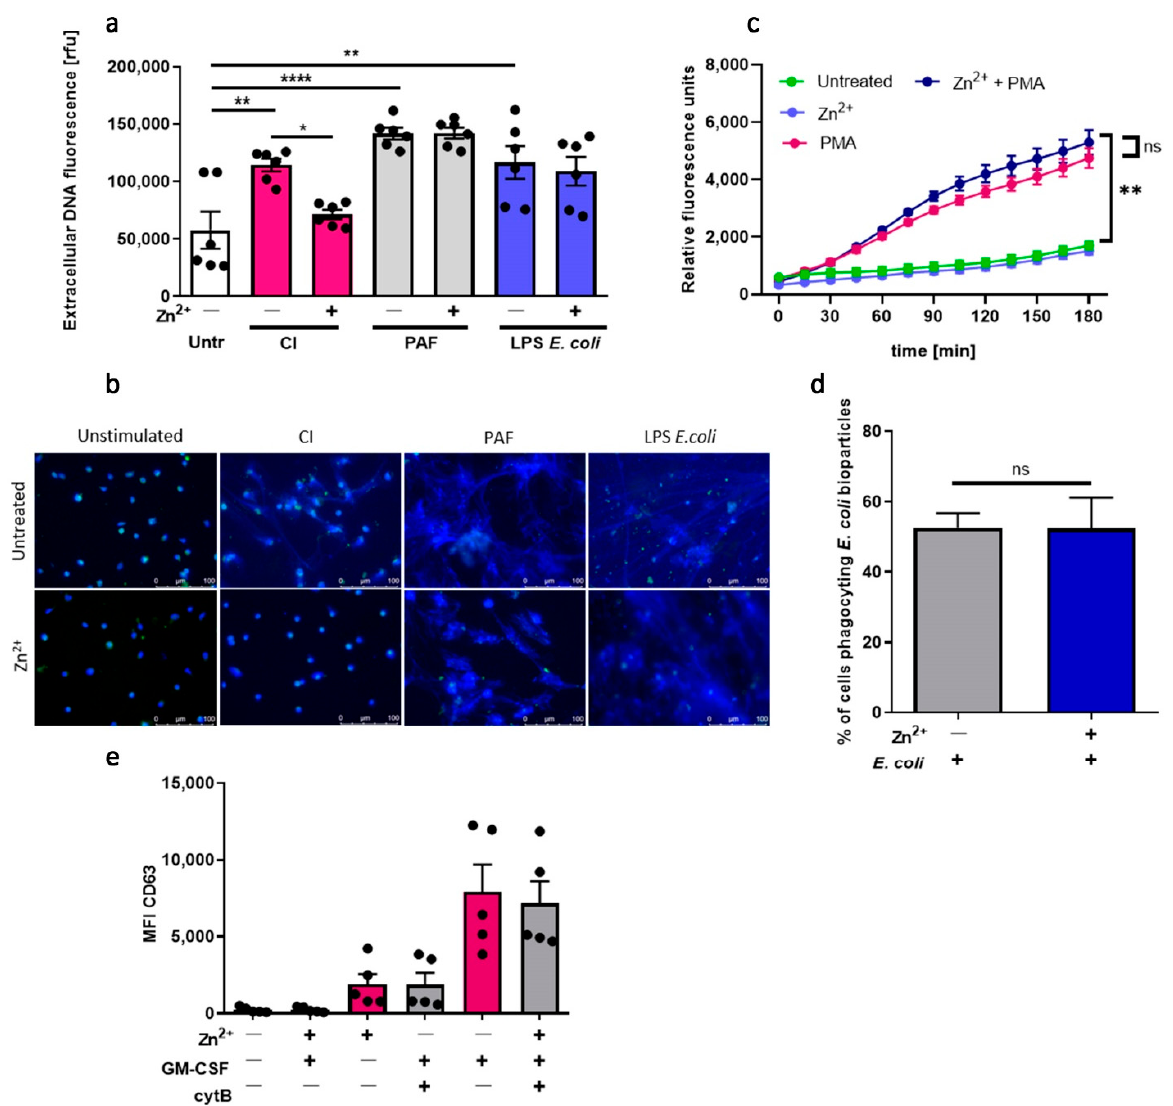
Figure 4. Zinc inhibits NETs release in neutrophils isolated from mice. Mice were sacrificed, and bone marrow neutrophils were isolated. ( a , b ) Neutrophils were stimulated to release NETs with 4 µ M CI, 10 µ M PAF or 20 µ g/mL LPS E. coli . NETs release was ( a ) measured fluorometrically and ( b ) analyzed by fluorescent microscopy. ( c ) Neutrophils were incubated with 4 µ g/mL DHR 123 and stimulated with 100 nM PMA. ROS production was measured fluorometrically. ( d ) Cells were incubated with E. coli bioparticles, and the percentage of cells phagocyting bacteria was analyzed by flow cytometry. ( e ) Neutrophils were primed with GM-CSF, incubated with cytochalasin B, C5a and labeled with anti-CD63. Data are shown as means ( a , d , e ) + SEM; (c) ± SEM; ( a , e ) with individual values. One-way ANOVA with post hoc ( a ) Bonferroni’s test, ( d ) Holm–Sidak’s test; ( e ) Dunn’s test. Two-way ANOVA with post hoc ( c ) Dunnett’s test. ( a , b ) n = 6, ( c ) n = 4, ( d ) n = 7, ( e ) n = 5; * ( p ≤ 0.05), ** ( p ≤ 0.01), **** ( p ≤ 0.0001). NE: neutrophil elastase. 3.5. Low Zinc Diet Increases NETs Release and Neutrophils’ Degranulation To evaluate the biological relevance of our findings and to further study the role of zinc disturbances on innate immunity, we fed two separate groups of mice with low-zinc